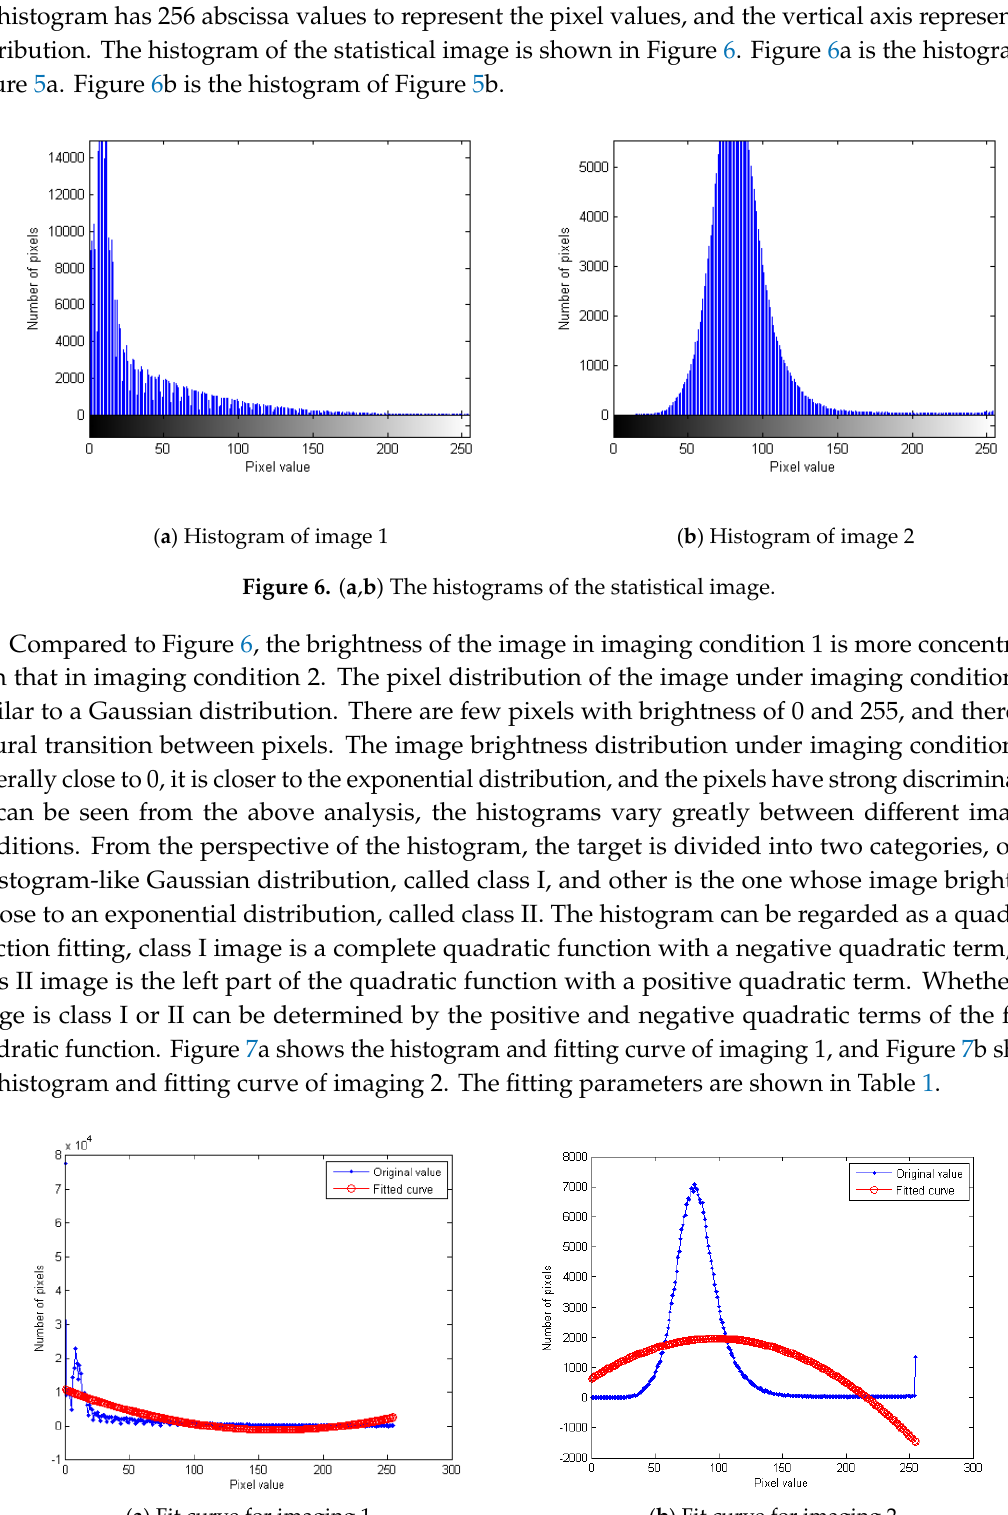
( a ) Fit curve for imaging 1 Figure 7. ( a , b ) Histogram and quadratic function fitting curve.